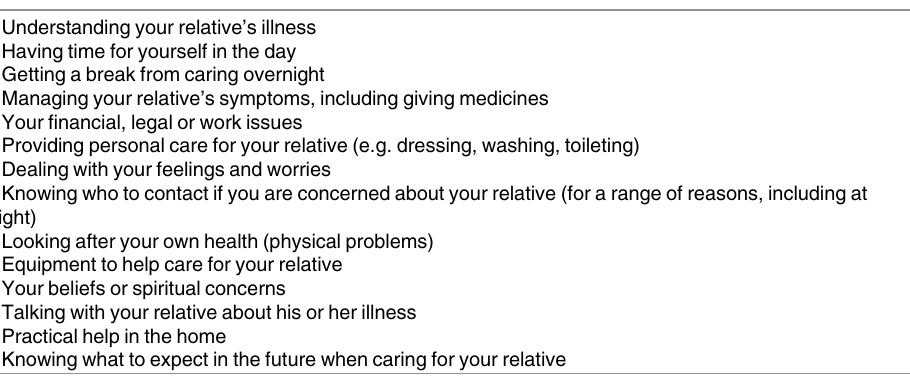
Table 1. The CSNAT